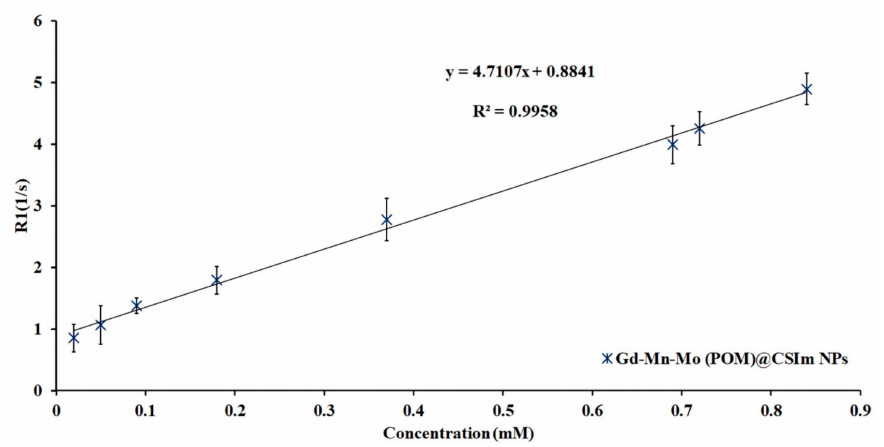
Figure 5. Relaxivity (r 1 ) plots of POM@CSIm at various concentrations of